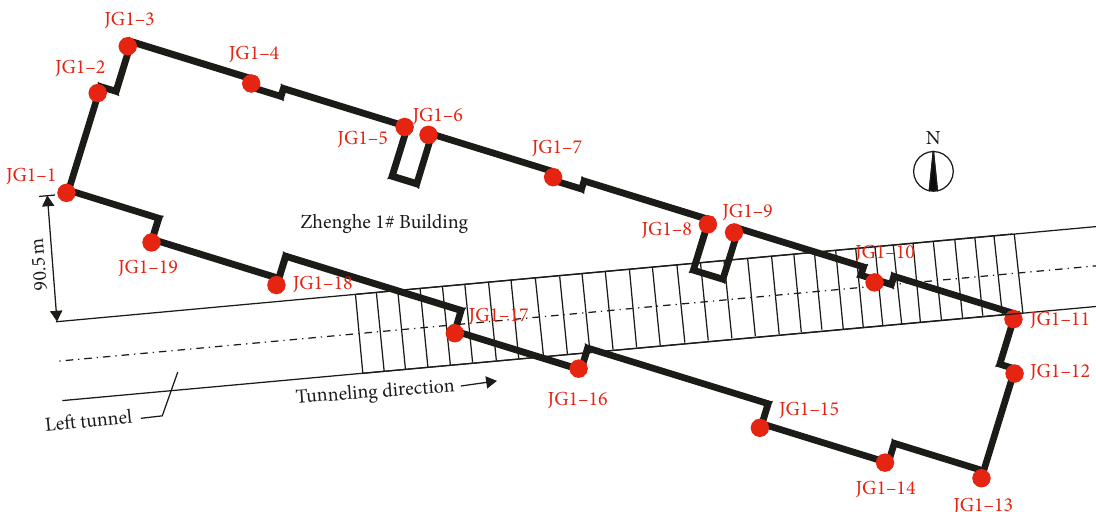
Figure 7: Layout drawing of the monitoring points in Zhenghe 1#